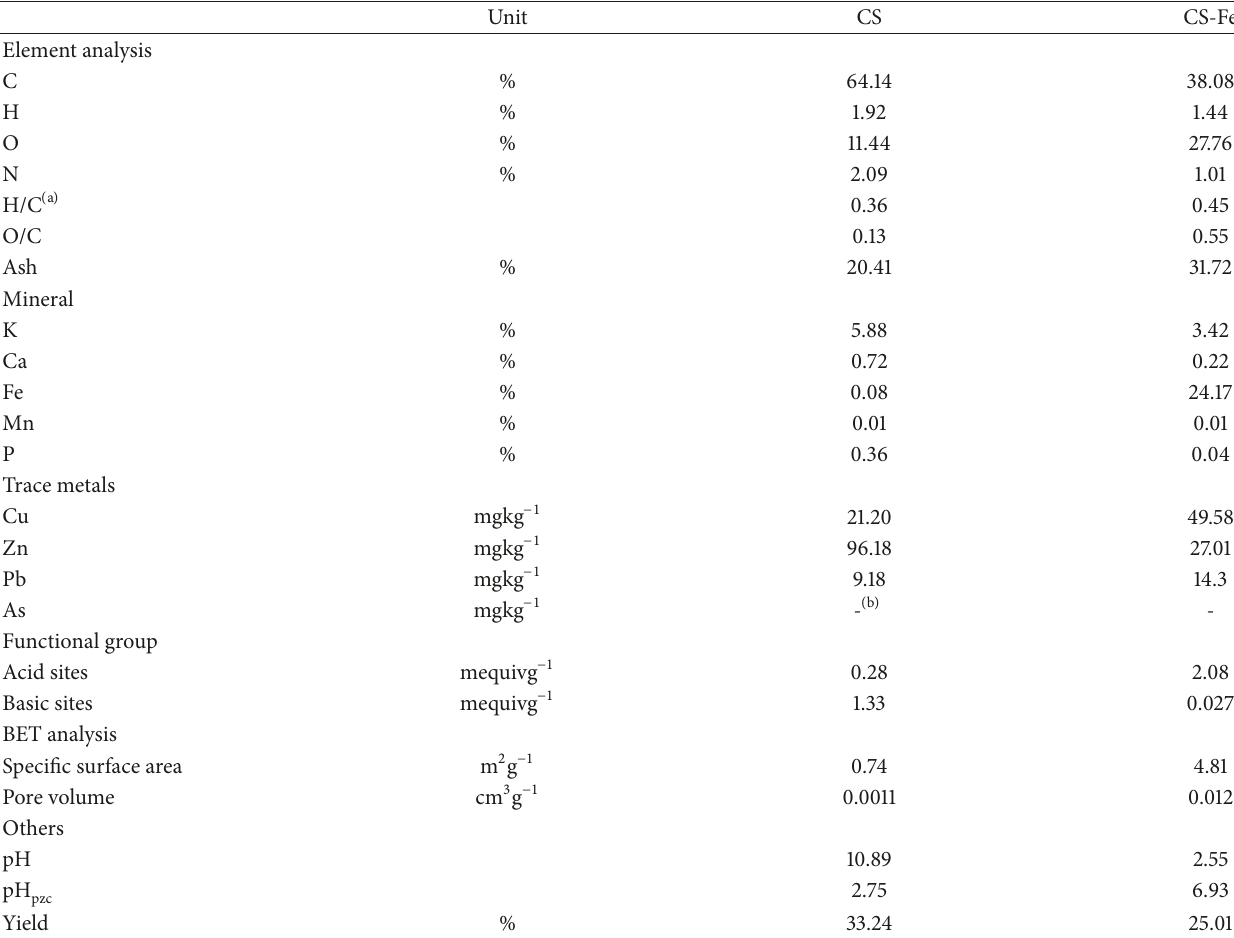
Table 1: Characteristics of the